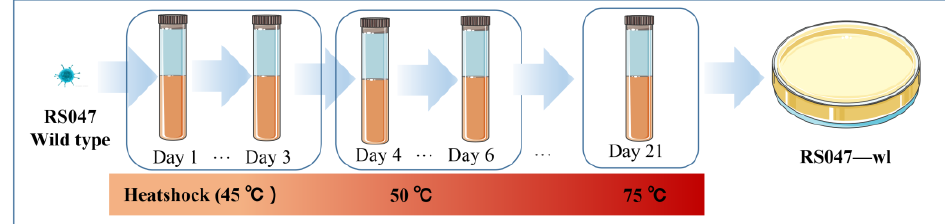
Figure 1. Neighbor-joining tree constructed based on the 16S rRNA sequences in WT RS047 and RS047-wl.